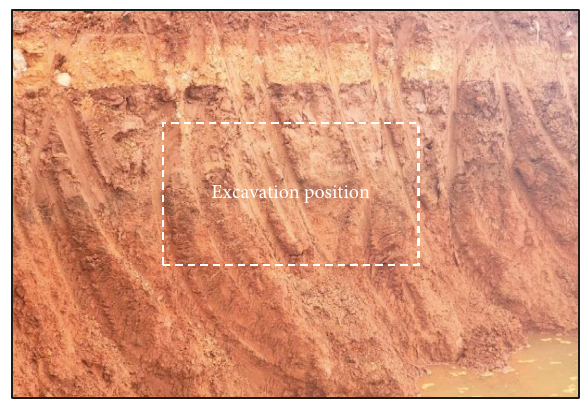
Figure 2: Excavation position of the soil